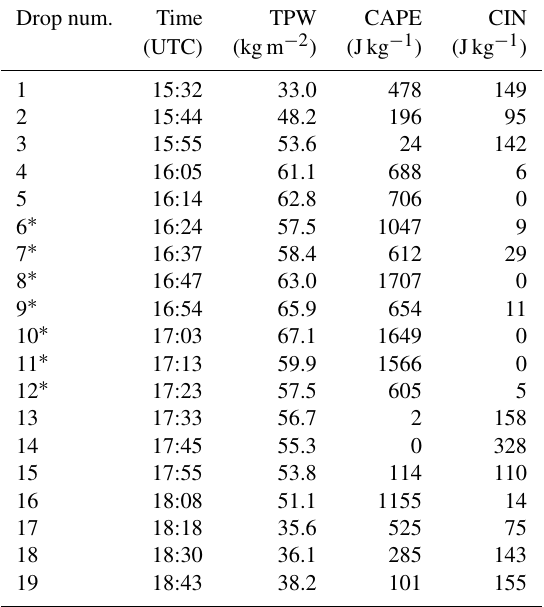
Table 1. Summary of dropsondes from PREDICT Research Flight 9 (RF09) on 2 September. Drop